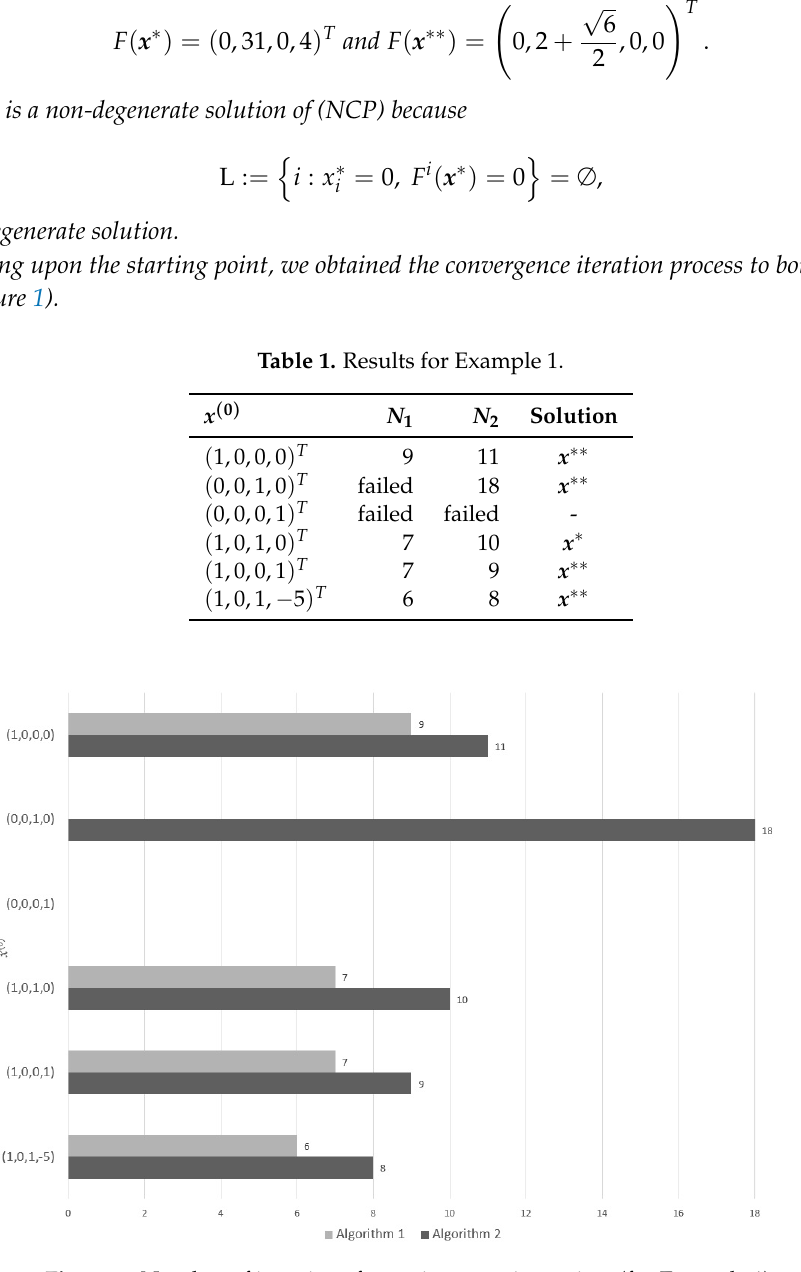
Figure 1. Number of iterations for various starting points (for Example